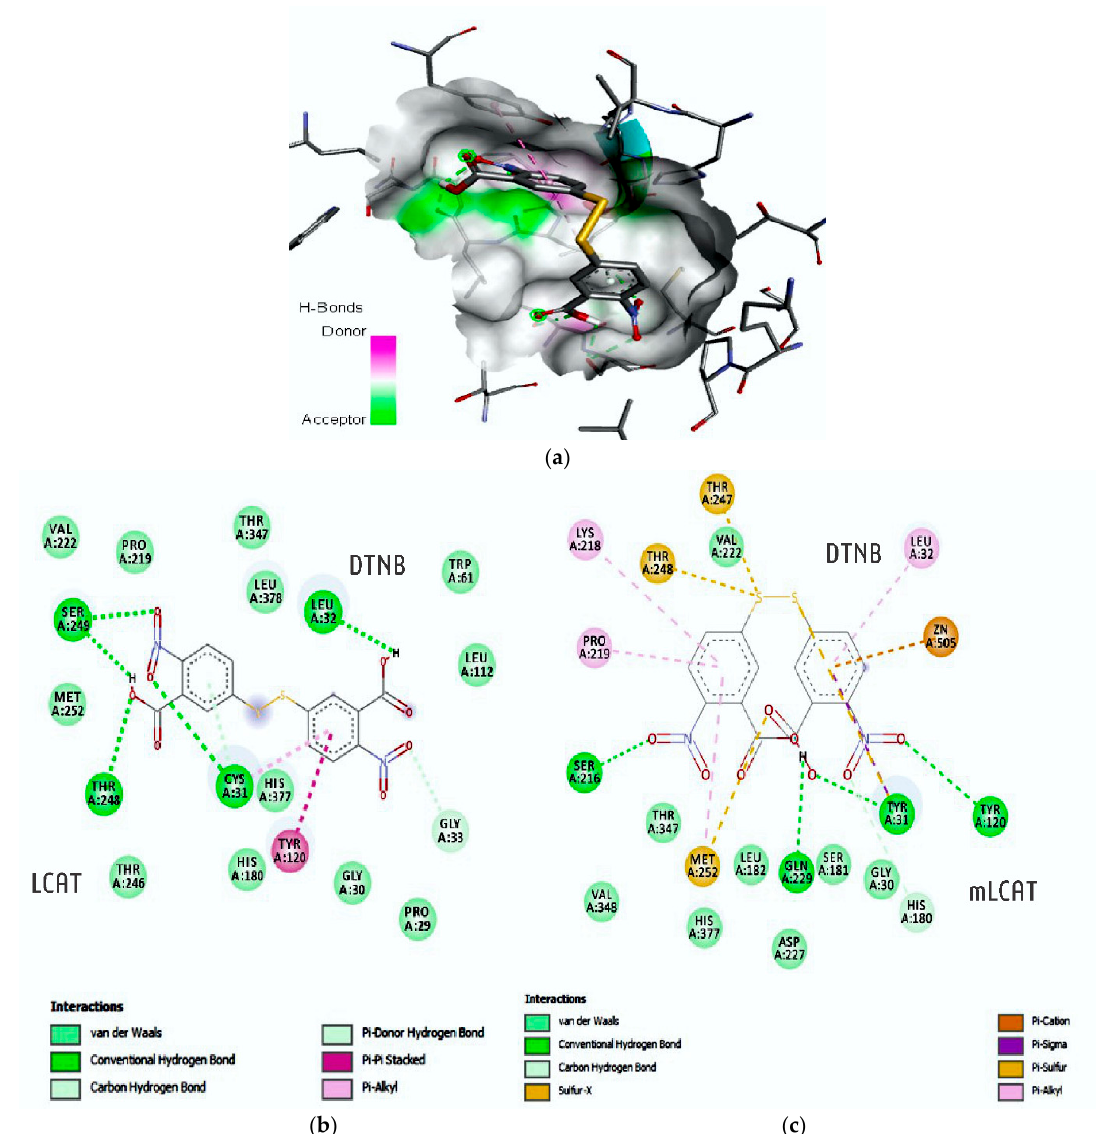
Figure 6. 3D ( a ) e 2D ( b ) arrangement of residues involved in the interaction of DTNB with nLCAT (B) (presence of Cys31), interaction with mLCAT ( c ) (presence of Tyr31). Residues were observed by the Accelrys visualizer software, version 4.5.